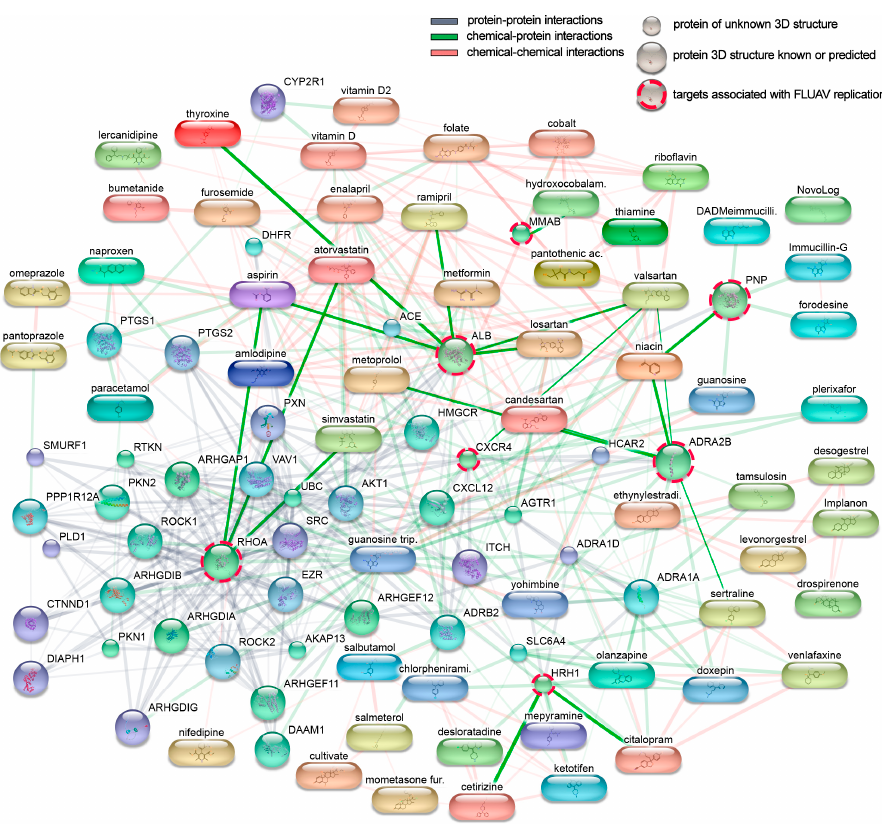
Figure 2. Direct and downstream cellular targets of 45 active components of commonly prescribed medicines. Targets associated with FLUAV replication are marked with red dashed circles, and interactions between them and commonly prescribed drugs are highlighted.